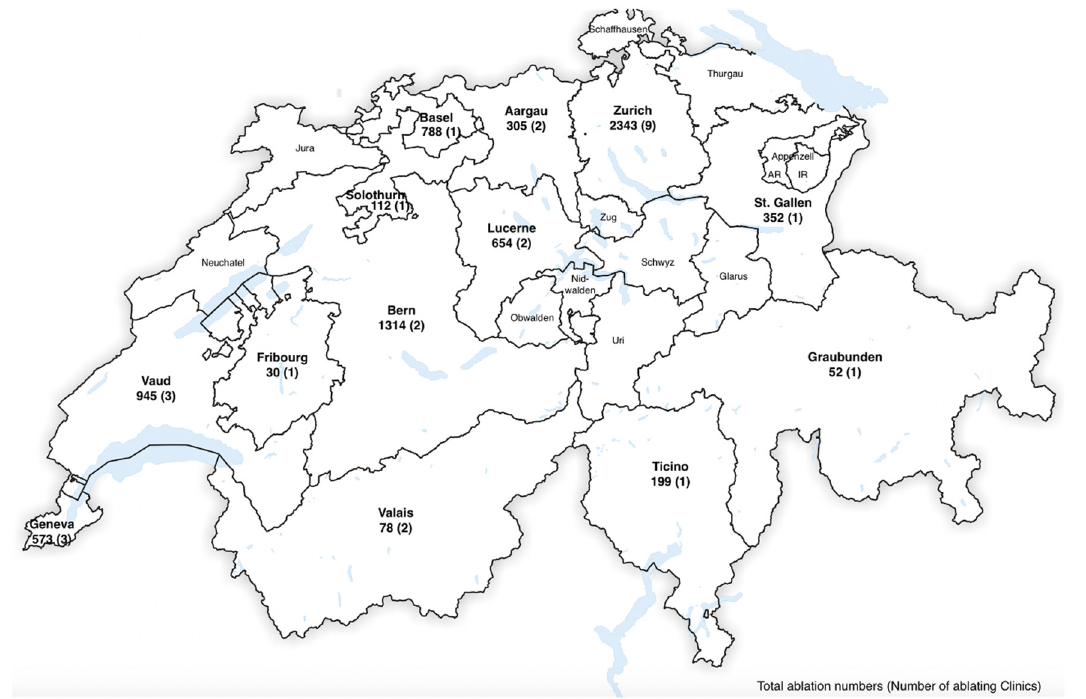
Figure 3. Number of catheter ablations and ablating centers across Swiss cantons (2019 data).